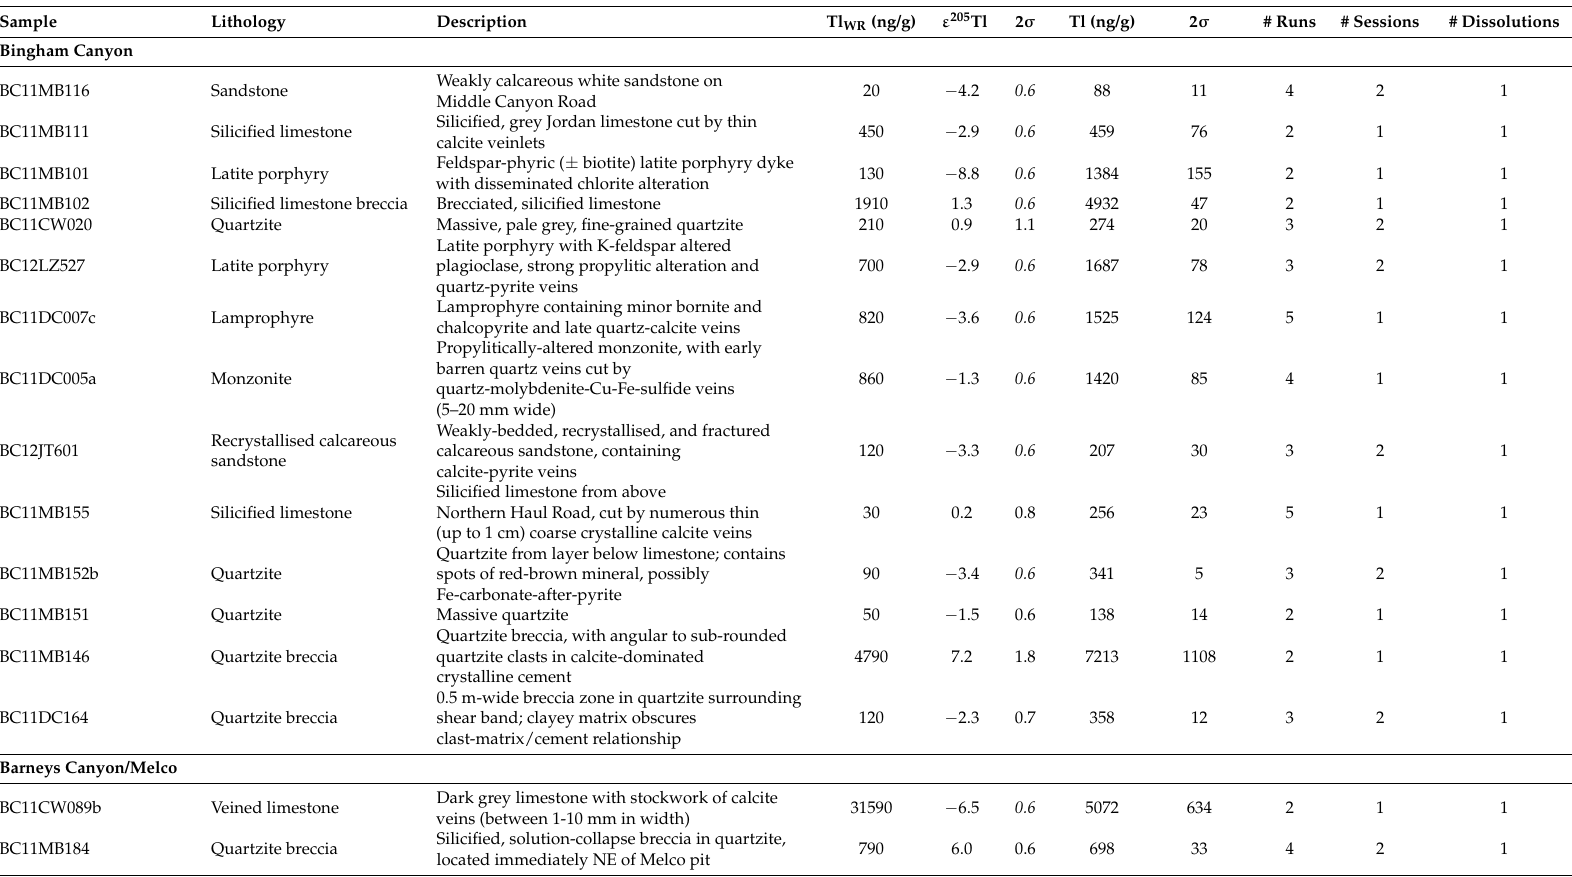
Table 1. Thallium concentrations and isotope compositions in samples from the Bingham district, compared to standard reference materials; values of 2 σ in italics originally returned values <<0.6, and were consequently assigned a more conservative value on the basis of multiple analyses of the Aldrich